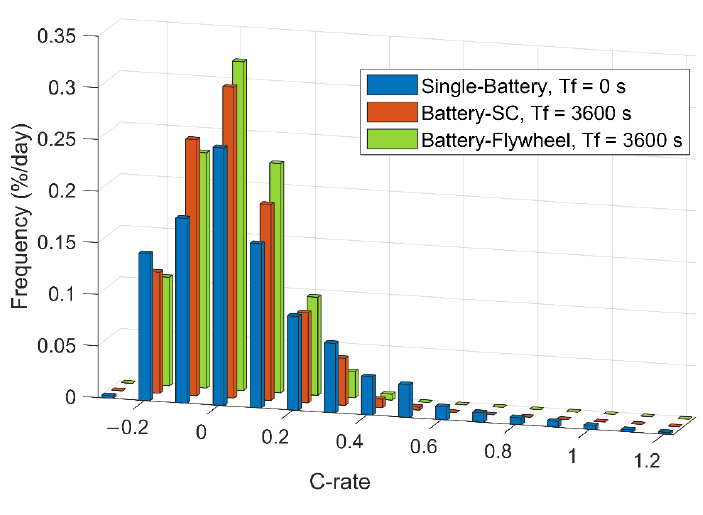
Figure 20. Distribution of the battery current rates during one day in a wind-powered household- prosumer system (0 C is the interval between ± 0.04 C).